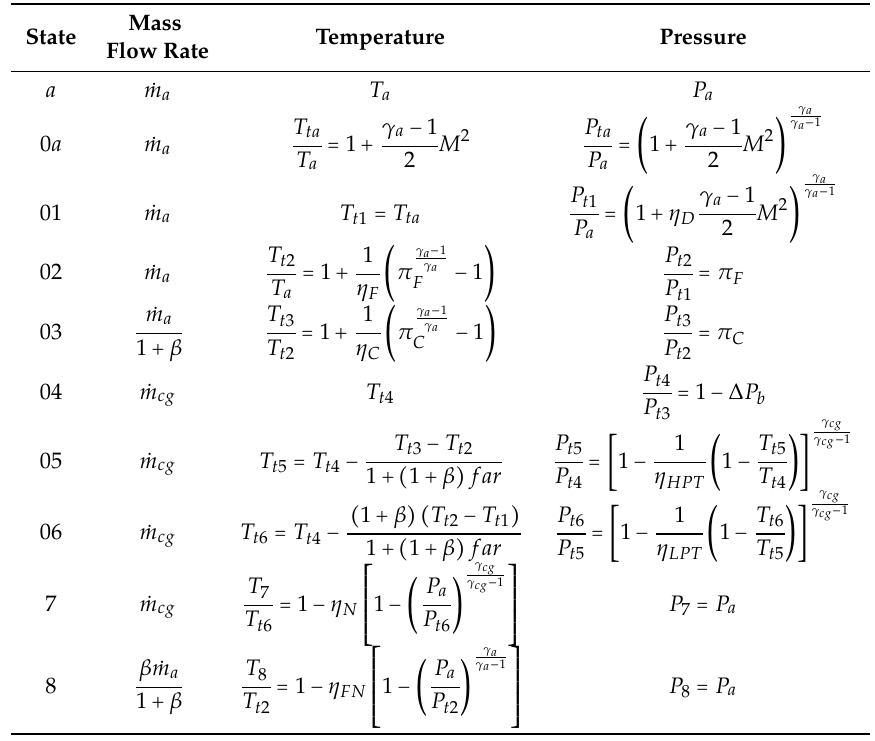
Table 2. Thermodynamic states of the turbofan